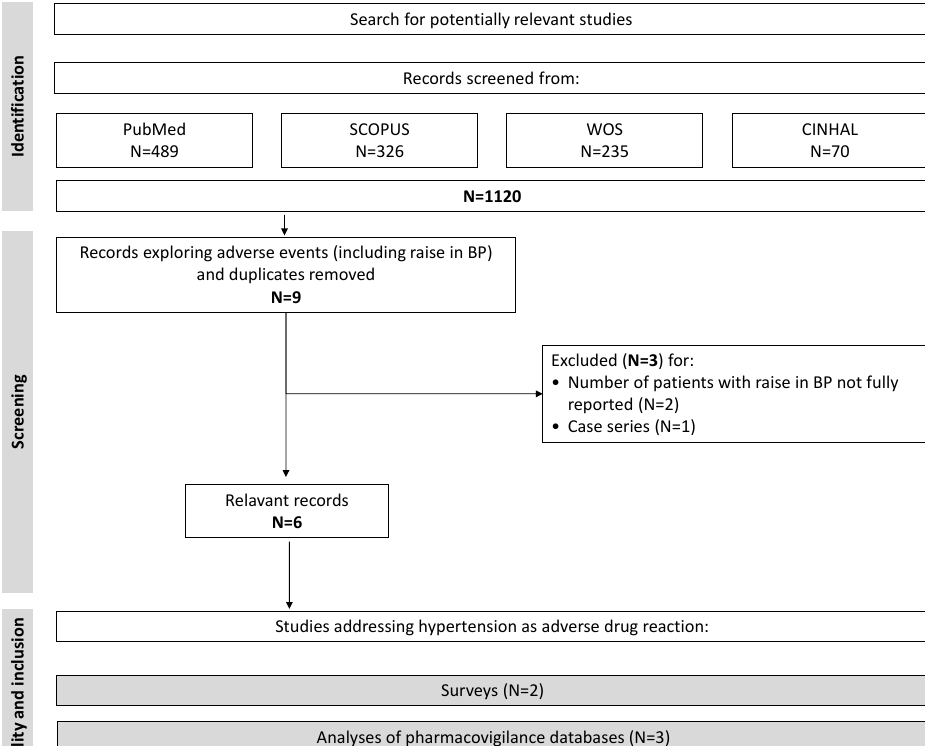
Table 2. Main features of studies included in the analysis.